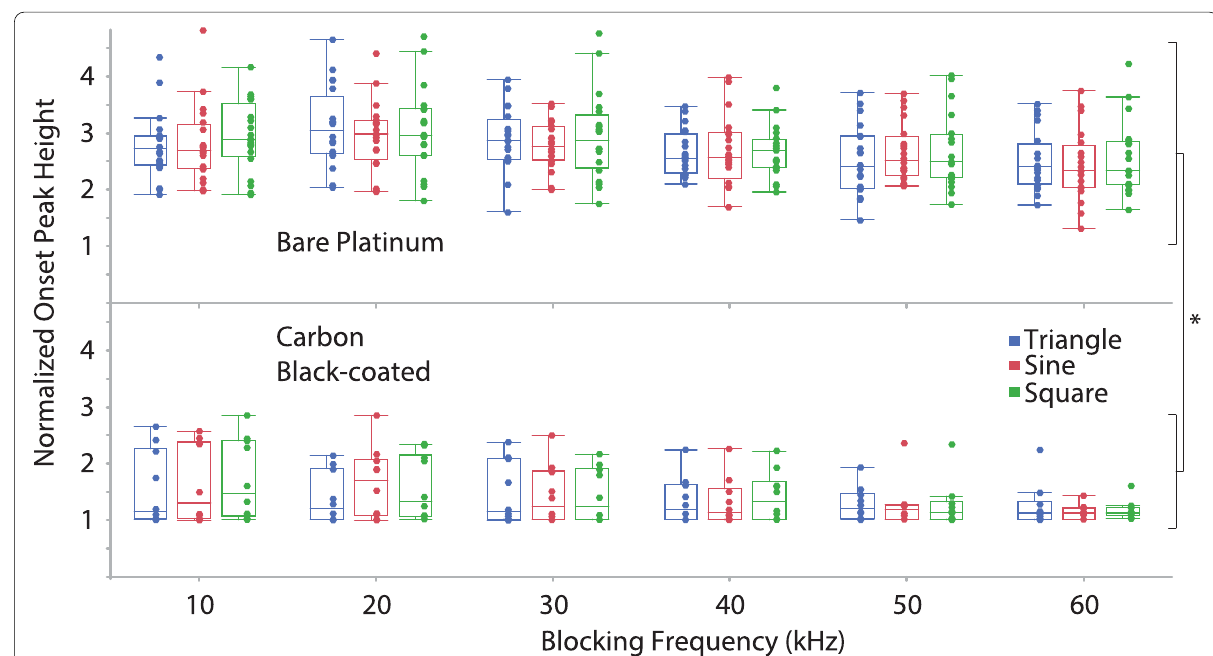
Fig. 8 Onset responses for the onset peak for both electrode types. Onset is unaffected by waveform shape. Onset response was significantly affected by blocking frequency ( p < 0.001) but not waveform shape. Overall (* p < 0.001) and at each frequency, carbon black coating yielded significantly lower onset peak height ( p <